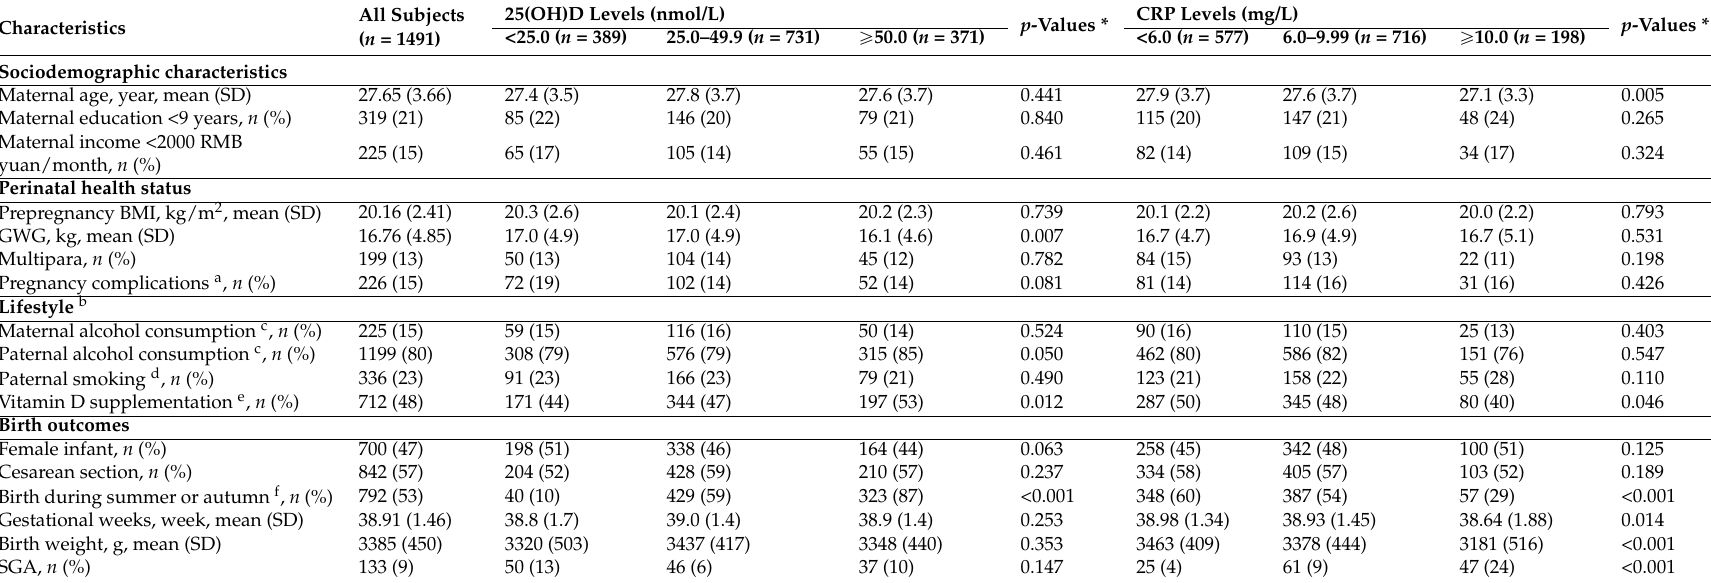
Table 1. Characteristics of mother-infant pairs according to cord blood 25(OH)D and CRP